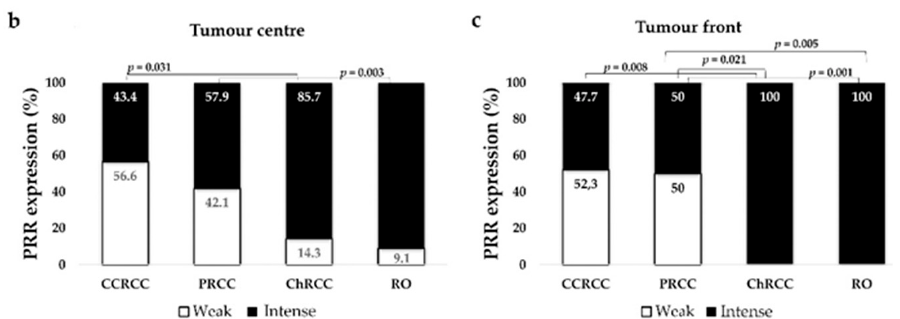
Figure 2. Immunohistochemical PRR staining in kidney tumours. ( a ) PRR immunostaining of different tumor subtypes (clear cell renal cell carcinoma (CCRCC); papillary renal cell carcinoma (PRCC); chromophobe renal cell carcinoma (ChRCC); renal oncocytoma (RO)). Original magnification, × 250. PRR staining intensity both at centre ( b ) and front ( c ) of tumours was grouped as weak and intense. ChRCCs and RO showed intense PRR staining, whereas CCRCC and PRCC showed